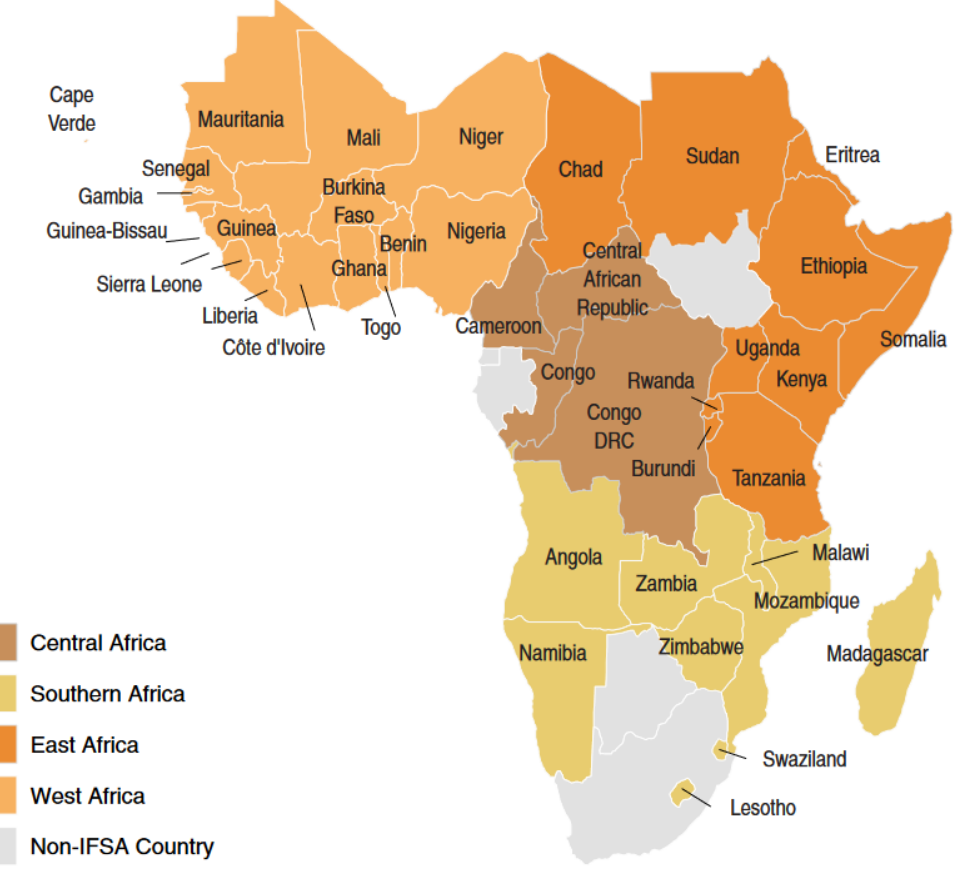
Figure 3. Map of the Sub-Saharan African countries. Source: adapted from [41]. Accessed on 10th August 2022